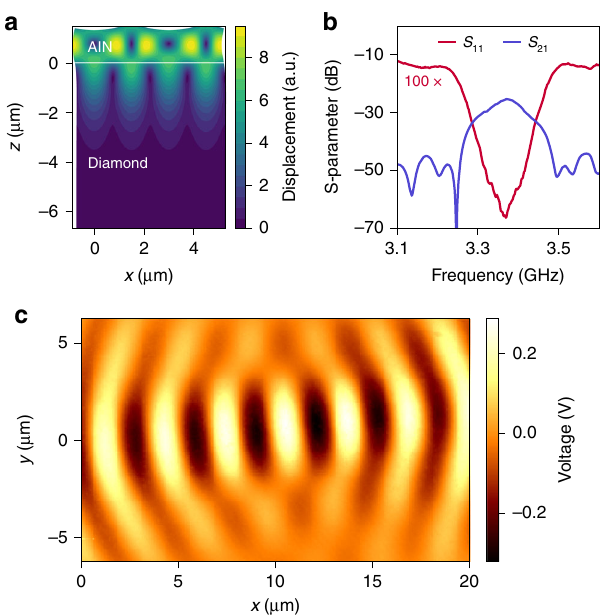
Fig. 2 Characterization of SAW transducers. a Total displacement pro fi le of the acoustic mode in a cross-section of the device, obtained from fi nite element simulation. The white horizontal line indicates the interface between AlN and diamond. SiVs are located 100 nm below this line. b Room temperature measurement of electrical S-parameters between the transmitter and receiver IDTs. The S 11 plot is magni fi ed 100 ´ along the vertical axis. c Microwave impedance microscopic image showing the surface electric potential at the focus of the transducers under continuous- wave excitation. The potential is proportional to the SAW amplitude and demonstrates focusing of the SAW on the surface.